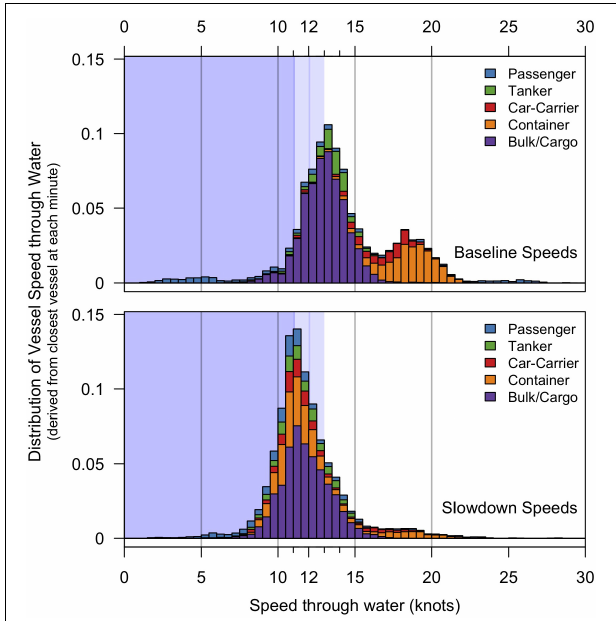
FIGURE 4 | Stacked plot of commercial vessel speeds through water at baseline (Top) , and during the slowdown trial period (Lower) , by vessel type. For the slowdown participation levels, the target vessel speed through water was set at 11 knots, and AIS-calculated speeds within 1 knot and 2 knots are assessed in the panels relative to x -axis ticks at 12 and 13 knots.